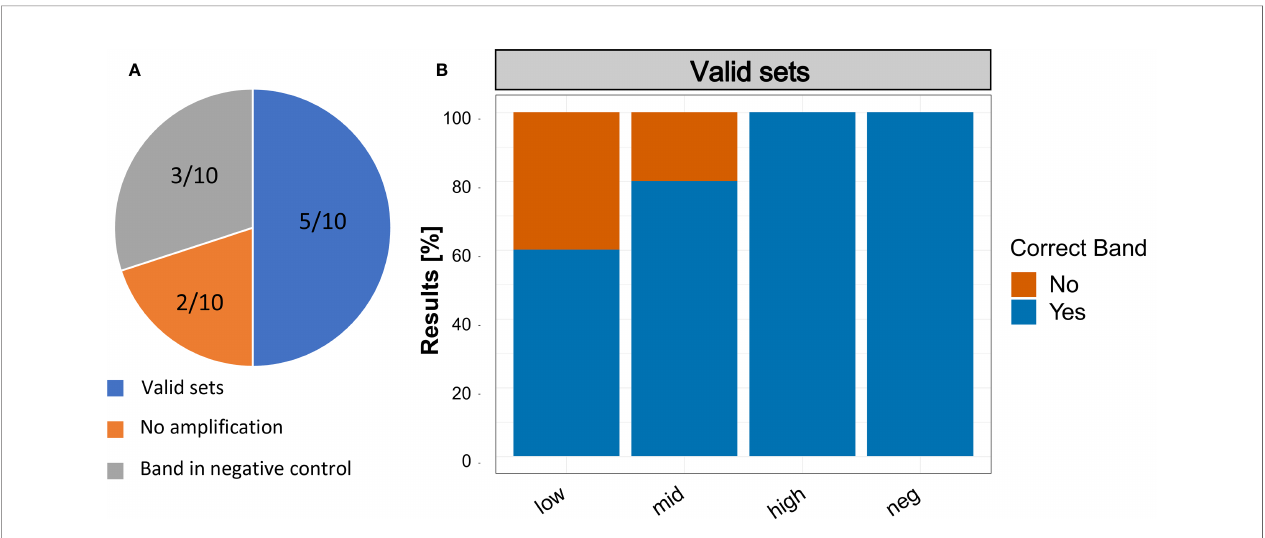
FIGURE 7 | Results of the Recombinase Polymerase Ampli fi cation trials with non-scientist users. (A) Summary of the results reported by the participants. Valid sets: Participants that had no band in the negative control and a band in at least one of the three samples with Sabella spallanzanii DNA; No Ampli fi cation: Participants that did not report an ampli fi cation in any of the samples; Band in negative control: Participants that reported a band in the negative control. (B) Reported results of participants with ‘ Valid sets ’